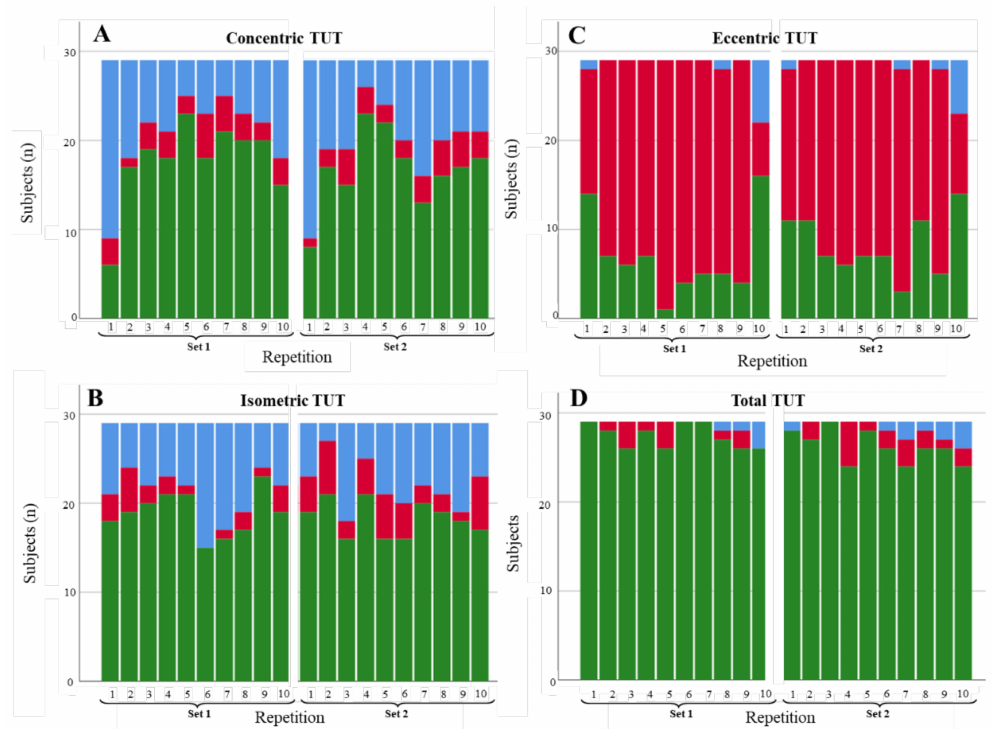
Figure 3. Degree of compliance of the TUTs for the fast abduction scenario by contraction phase: ( A ) concentric, ( B ) isometric, ( C ) eccentric, and ( D ) total. TUTs: in range = green; performed in less time than expected = blue; performed in more time than expected = red.